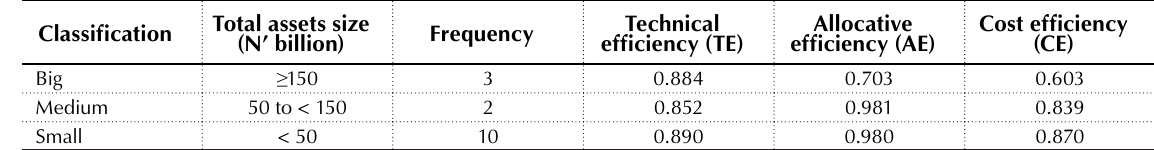
Table 1. Measured mean efficiency of the deposit money banks in